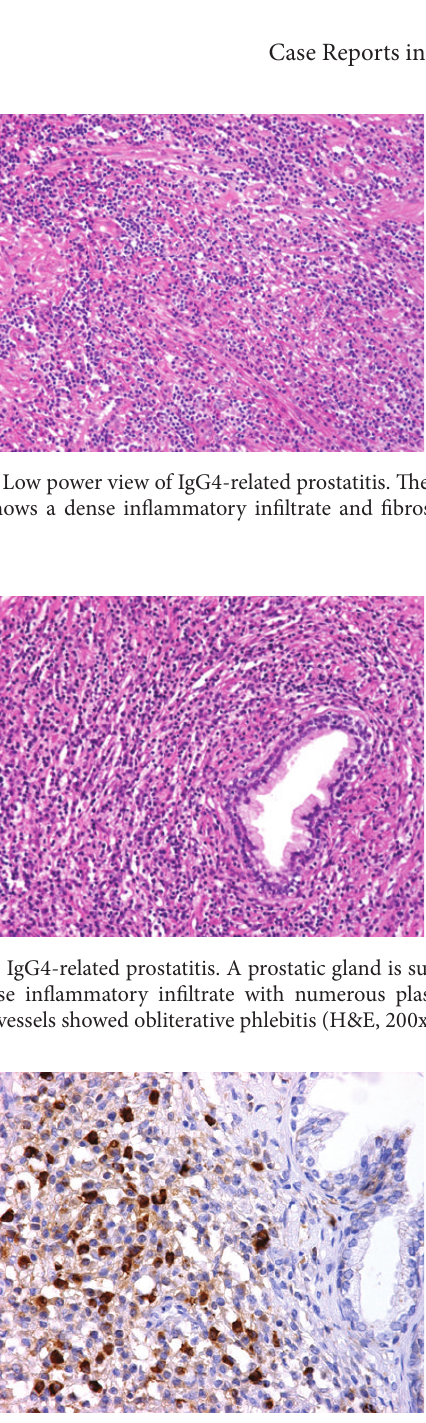
Figure 3: IgG4-related prostatitis. Numerous IgG4-positive plasma cells are shown ( > 10 cells/HPF) (Immunomarker against IgG4,